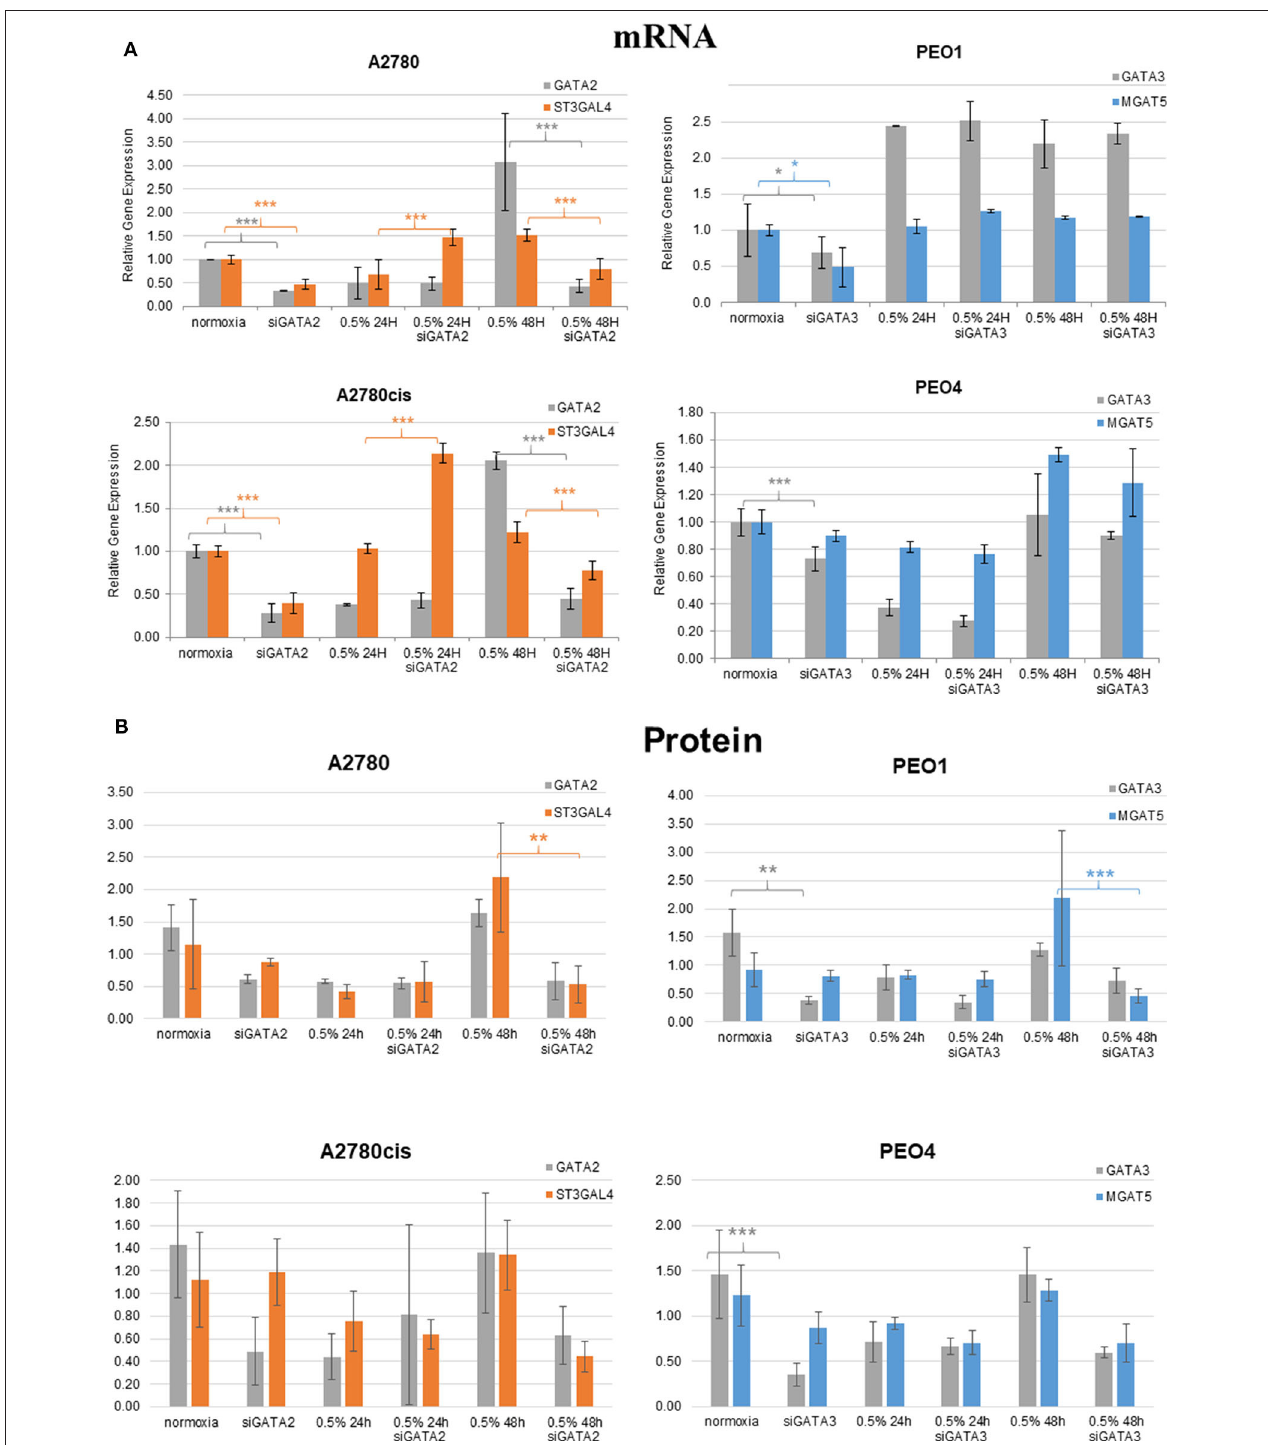
FIGURE 6 | Hypoxia alters mRNA expression of MGAT5 and ST3GAL4 through the regulation of GATA2 and 3. Expression of the GATA transcription factors (GATA2 and 3) and the glycosyltransferases MGAT5, ST3GAL4, in normoxia (21% O 2 ) and 0.5% hypoxia conditions, before and after siGATA knockdown at (A) the gene expression level, measured by quantitative RT-PCR analysis. Each sample represents of 2 biological replicates ( n = 2). The relative expression level of each gene was calculated according to the ddCt normalized with TBP; and at (B) the protein level as determined by densitometry (Image J)(Western blots are in Figure S5 ). Each condition was carried out on 3 biological replicates ( n = 3). Significant changes for only siRNA comparisons are starred: * P ≤ 0.05; ** P ≤ 0.01; *** P ≤ 0.001 ( T -test) and all P -values for this figure including comparisons of 24 and 48h hypoxia exposure with normoxia are in Table S4 .